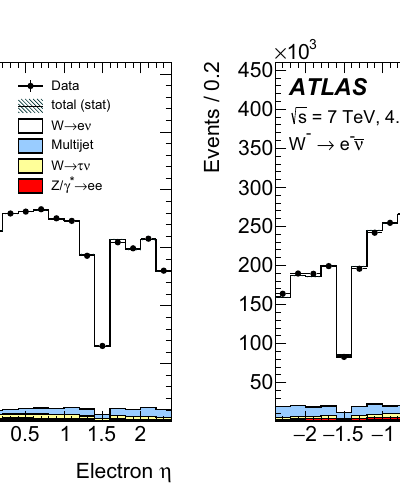
mated yield of multijet events. The sum of all expected background and signal contributions is shown as a solid line with a hashed band detail- ing the statistical uncertainty and labelled “total (stat)”. The legend lists only background sources with a visible contribution